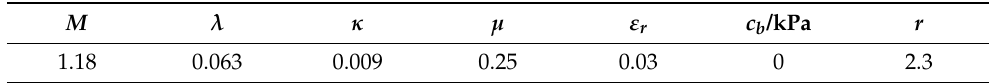
Table 3. Material parameters for Sandy